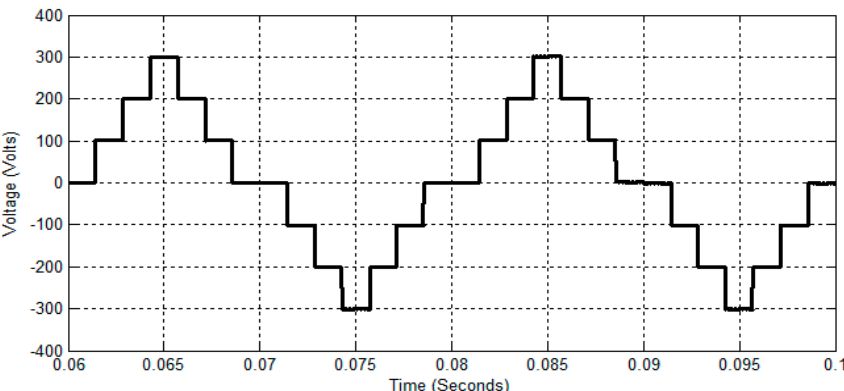
Figure 16. Inverter output across LGU using the EPCAD technique.